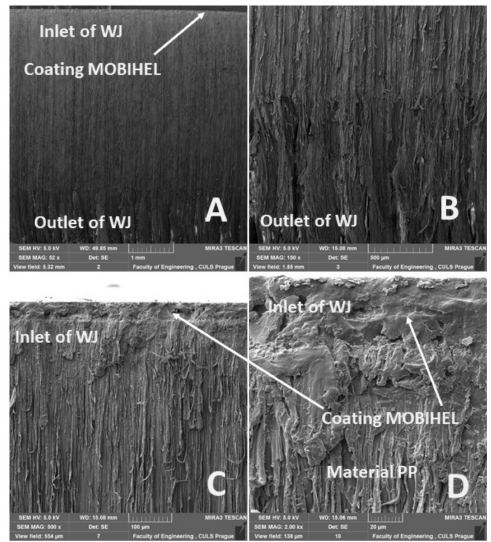
Figure 21. Cutting view of the tested PP + MOBIHEL, WJ technology, cutting head traverse speed 50 mm · min − 1 : ( A ) overall cut (MAG 52 × ); ( B ) detailed view of the outlet of WJ (MAG 150 × ); ( C ) detailed view of the inlet of WJ (MAG 500 × ); ( D ) detailed view of the interface of MOBIHEL coating and PP material (2000 ×